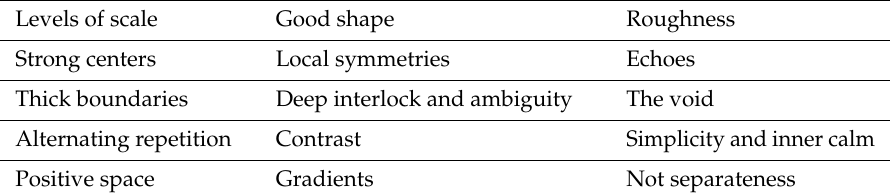
Table 1. The 15 structural properties of